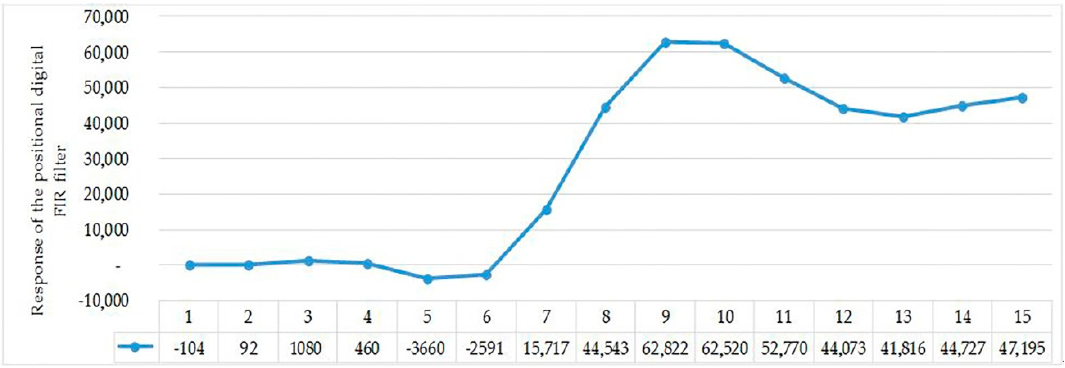
Figure 6. Response of the integer modular DF using scaling. The response of the DF, shown in Figure 5 (the response of the positional DF), coincides with the response shown in Figure 6 (the response of the integer modular DF using the developed scaling